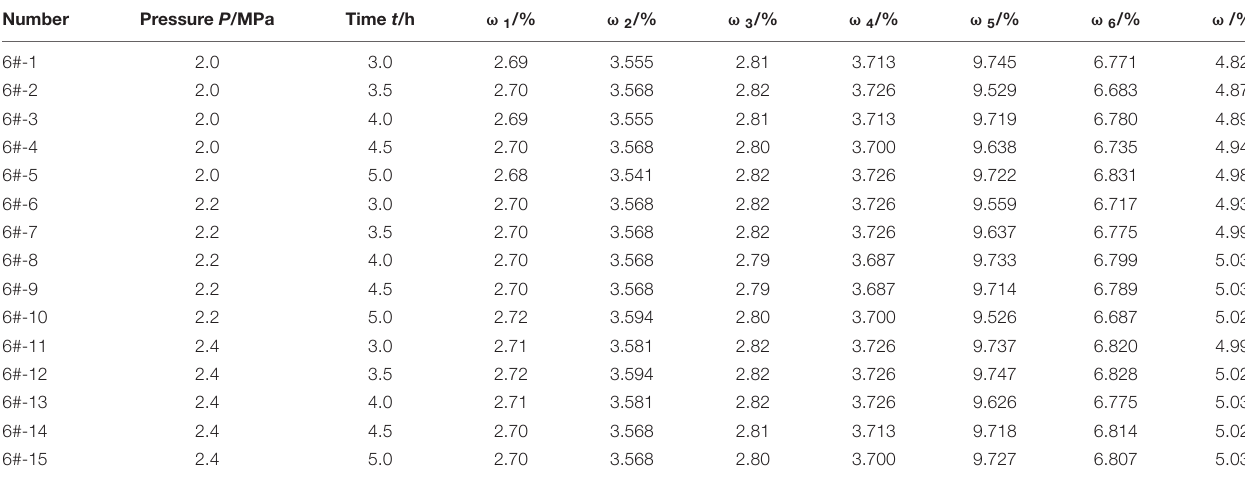
TABLE 4 | Determined contents of periclase in cement 6# under different autoclave pressures and autoclave time. Number Pressure P